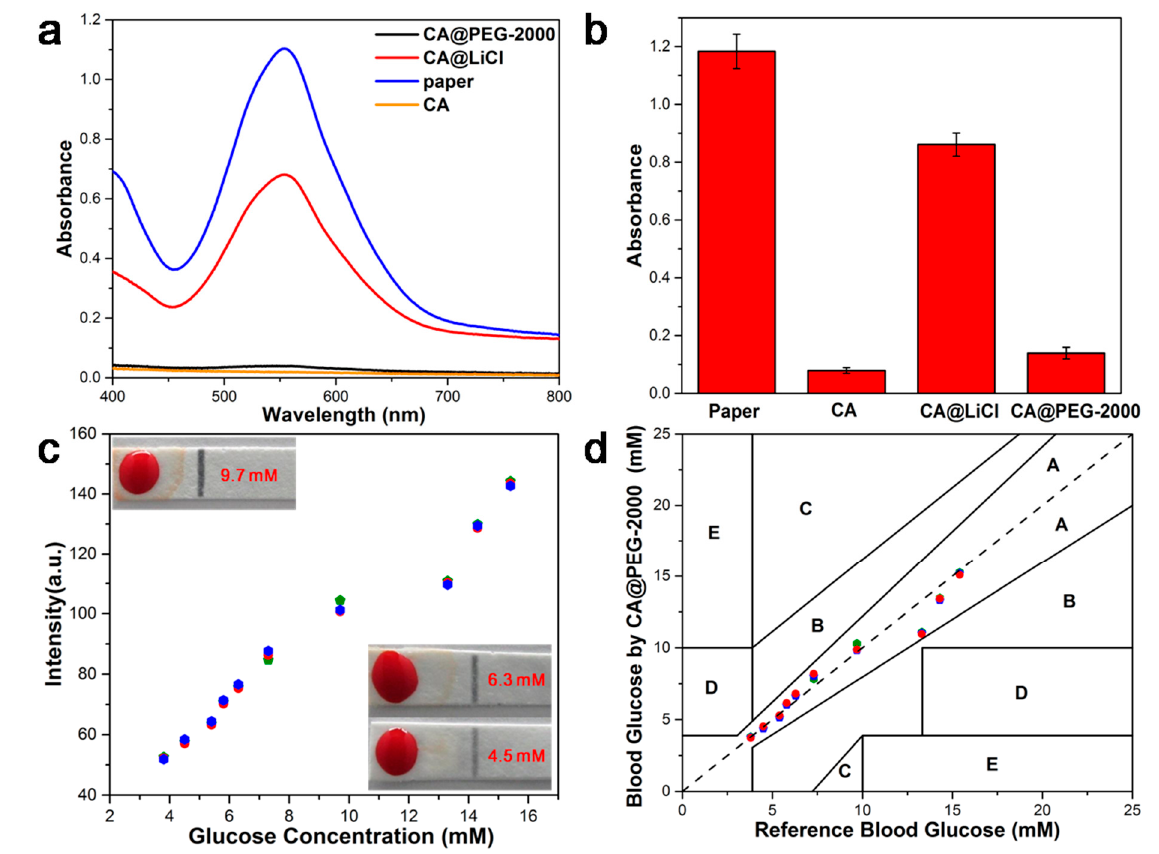
Figure 5. ( a ) UV-Vis absorption spectra of the chromogenic reaction with the different membranes. ( b ) Test repeatability of different membranes at 567 nm (standard deviation, n = 5). ( c ) The chro- mogenic intensity (figures with physical pictures). ( d ) Error grid analysis of real human blood samples in CA@PEG-2000 membranes.